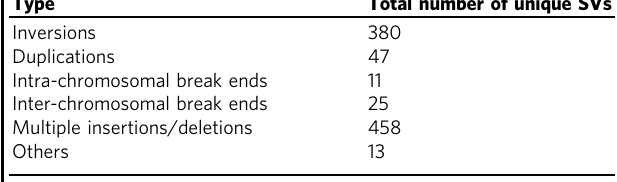
Table 2 Number of complex structural variations identi fi ed from the 154